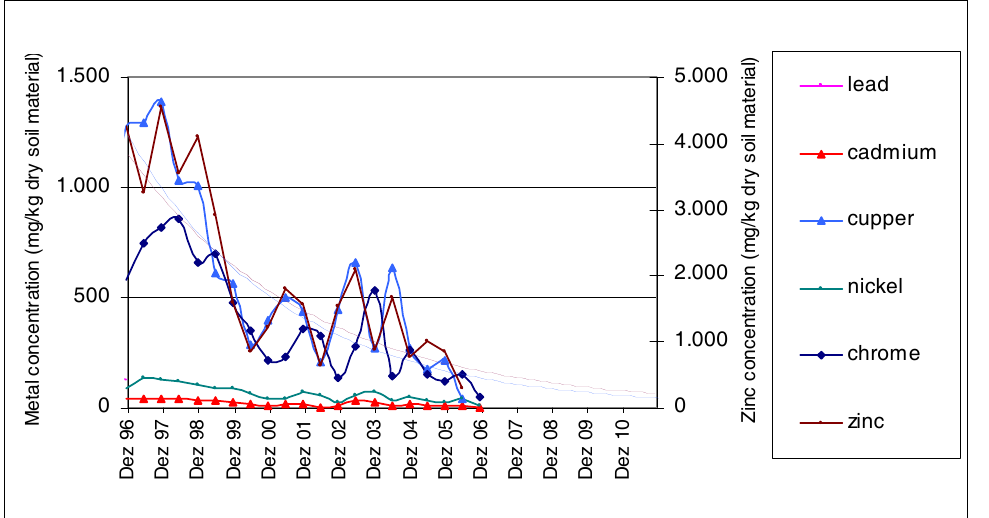
Fig 2. Results of Phragmites -based sludge